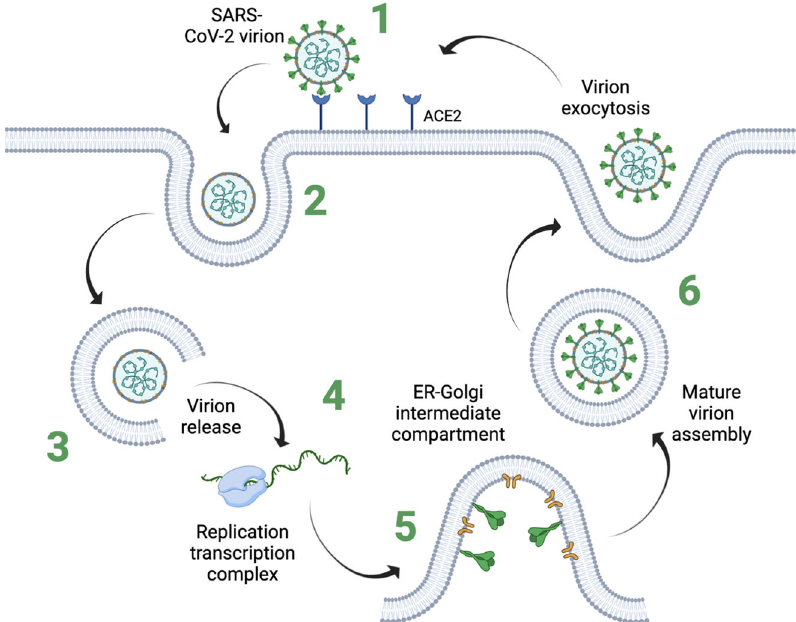
Fig.1|Viralreplicationcycle. TheSARS-CoV-2infectioncycleisdepictedinaschematicview,highlightingthesequentialandmodularnatureofthereplicationprocess. For each step of the viral replication cycle, viruses have evolved speci fi c molecular modules that are ef fi ciently compressed into single virion